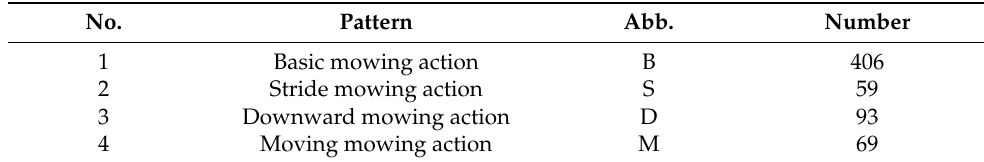
Table 5. Details of measures for analysis.